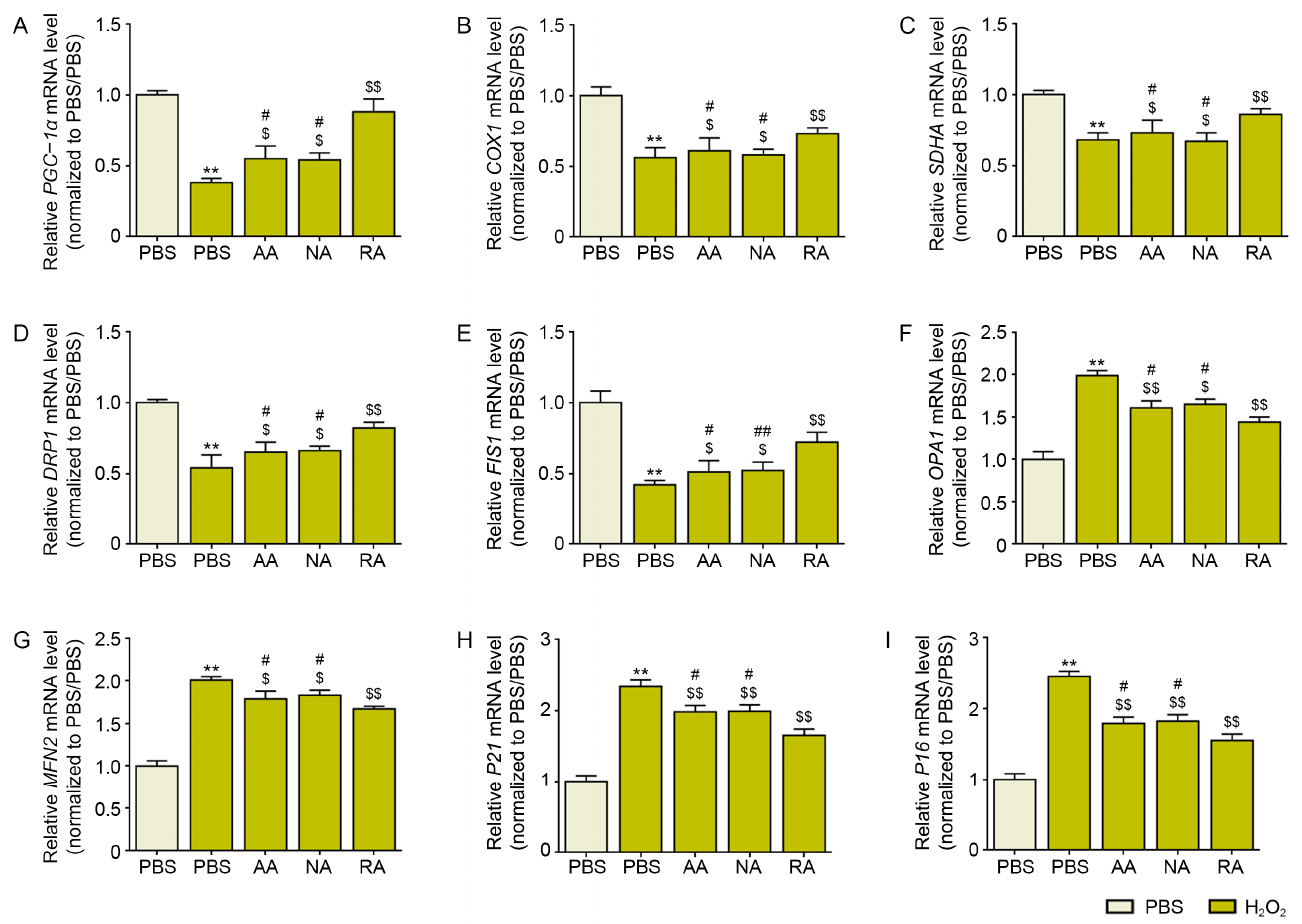
Figure 2. RA treatment decreased mitochondrial dysfunction and cellular senescence in H 2 O 2 -treated keratinocytes. ( A – G ) Mitochondrial dysfunction in H 2 O 2 -treated keratinocytes was confirmed by qRT-PCR. The levels of the mitochondrial biogenesis markers PGC-1 α ( A ), COX1 ( B ), and SDHA ( C ) were decreased by H 2 O 2 treatment but increased by RA treatment. The levels of the mitochon- drial fission markers DRP1 ( D ) and FIS1 ( E ) were also decreased by H 2 O 2 treatment but increased by RA treatment. The levels of the mitochondrial fusion markers OPA1 ( F ) and MFN2 ( G ) were increased by H 2 O 2 treatment but decreased by RA treatment. ( H , I ) Cellular senescence in H 2 O 2 - treated keratinocytes was confirmed by qRT-PCR. The levels of the cellular senescence markers P21 ( H ) and P16 ( I ) were increased by H 2 O 2 treatment but decreased by RA treatment. The data are presented as the mean ± SD of three independent experiments. **, p < 0.01, second bar vs. first bar; $, p < 0.05 and $$, p < 0.01, vs. second bar; #, p < 0.05 and ##, p < 0.01, vs. fifth bar (Mann–Whitney U test). AA; ascorbic acid, COX; cytochrome c oxidase, DRP1; dynamin-related protein 1, FIS1; mitochondrial fission 1 protein, MFN2; mitofusin 2, NA; niacinamide, OPA1; optic atrophy protein 1, PBS; phosphate-buffered saline, PGC-1 α ; peroxisome proliferator-activated receptor γ